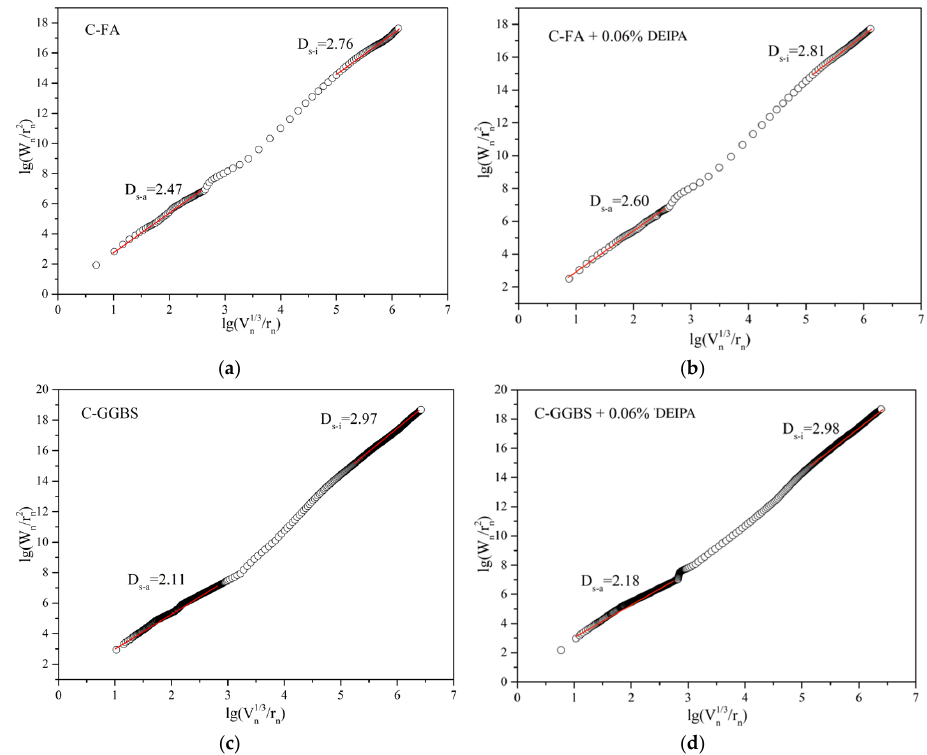
Figure 11. Logarithm plots of W n /r n2 versus V n1/3 /r n of C-FA/GGBS systems at 60 d, ( a ) C-FA, ( b ) C-FA with 0.06% DEIPA, ( c ) C-GGBS, ( d ) C-GGBS with 0.06% DEIPA.